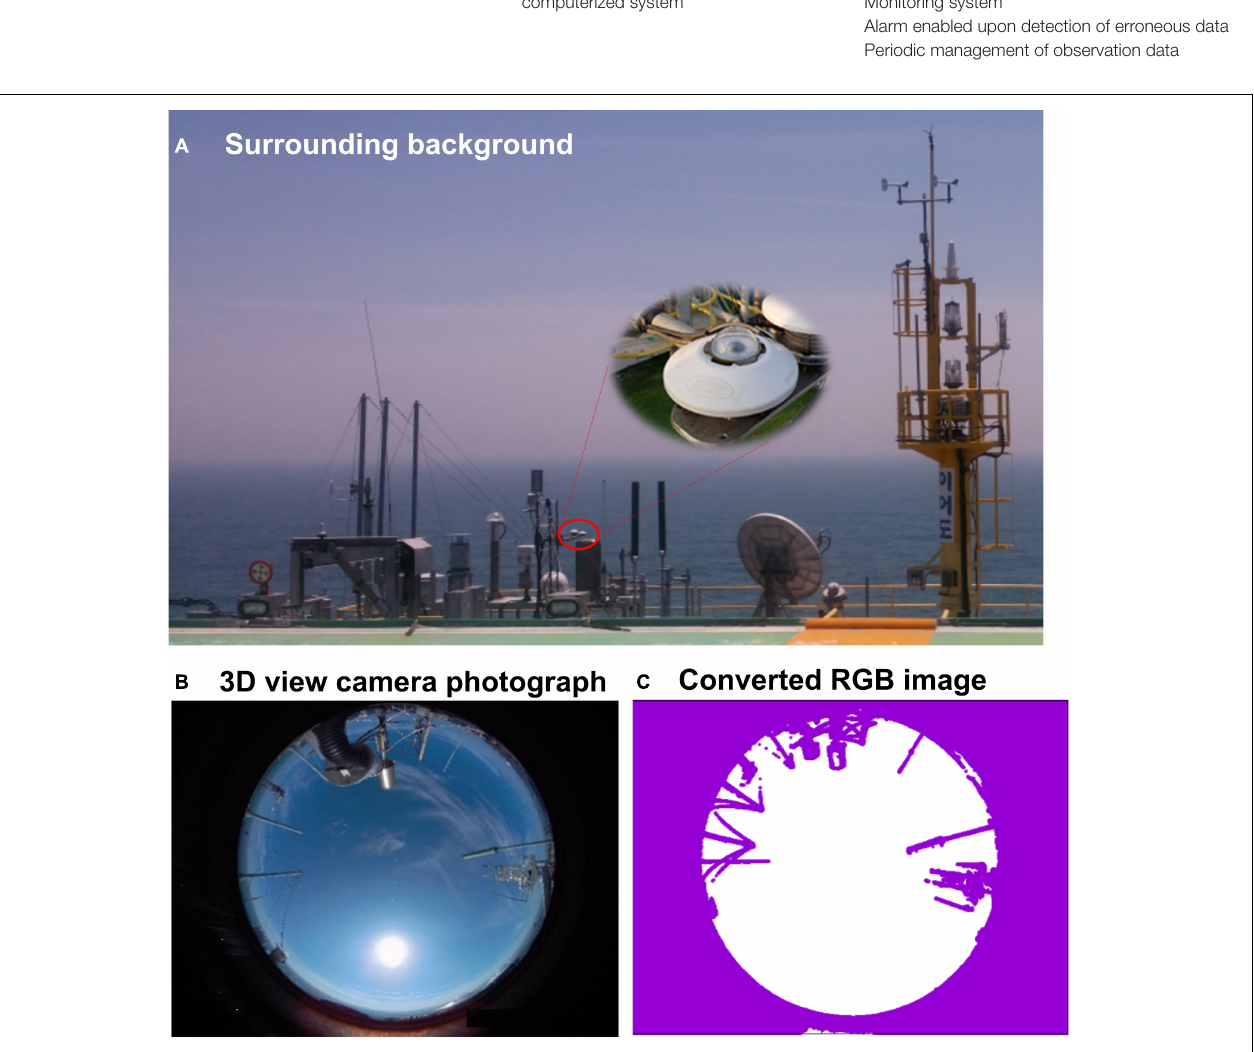
FIGURE 13 | (A) Background view around the radiation observation site and the process of shade analysis using the Ieodo ORS’s 360 ◦ view cameras; (B) 360 ◦ view camera photograph; and (C) the converted RGB image produced from (B) .